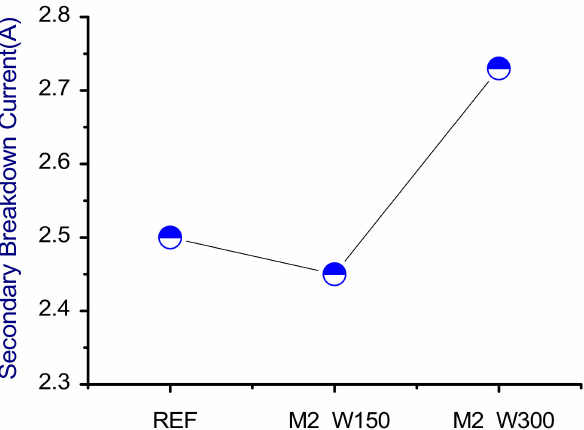
Figure 14. Secondary breakdown-current distribution chart of HV nLDMOSs with channel- width